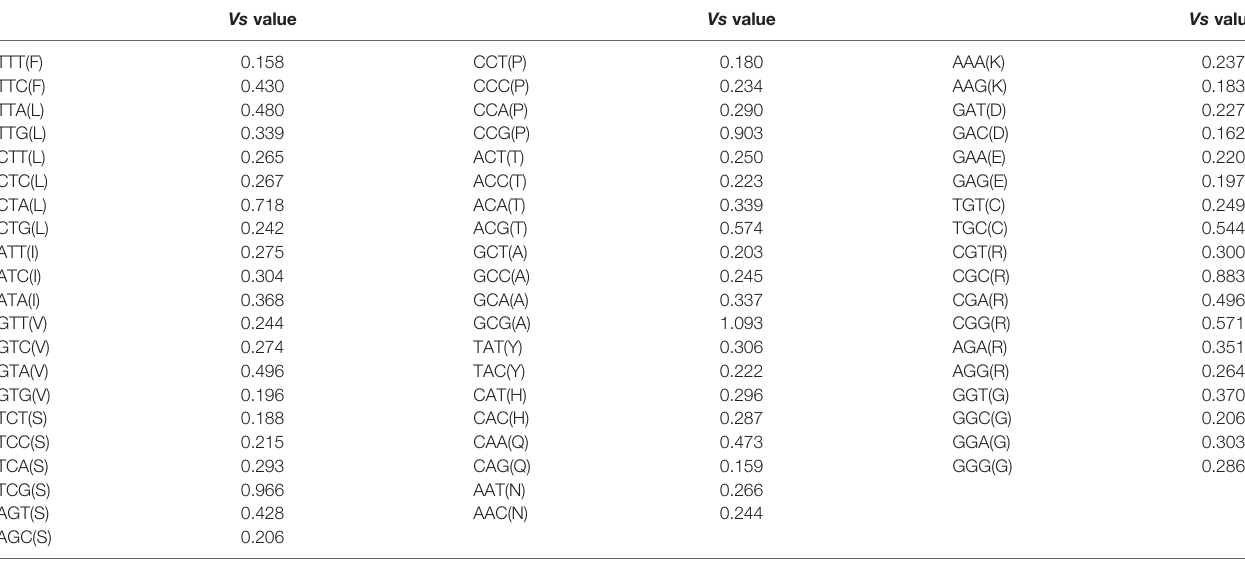
TABLE 1 | The dispersion magnitude of synonymous codon usages for atg13 genes across all species in this study. Vs value Vs value Vs value